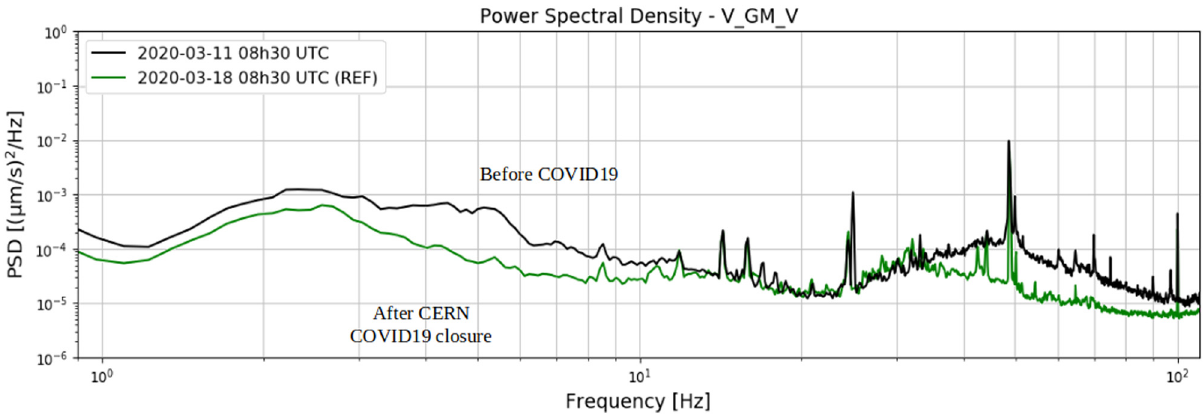
Figure 5: PSD graph for the 20 - min data block from seismic station at the surface ( CERNS ) before ( black line ) and after ( green line ) COVID - 19 CERN closure.